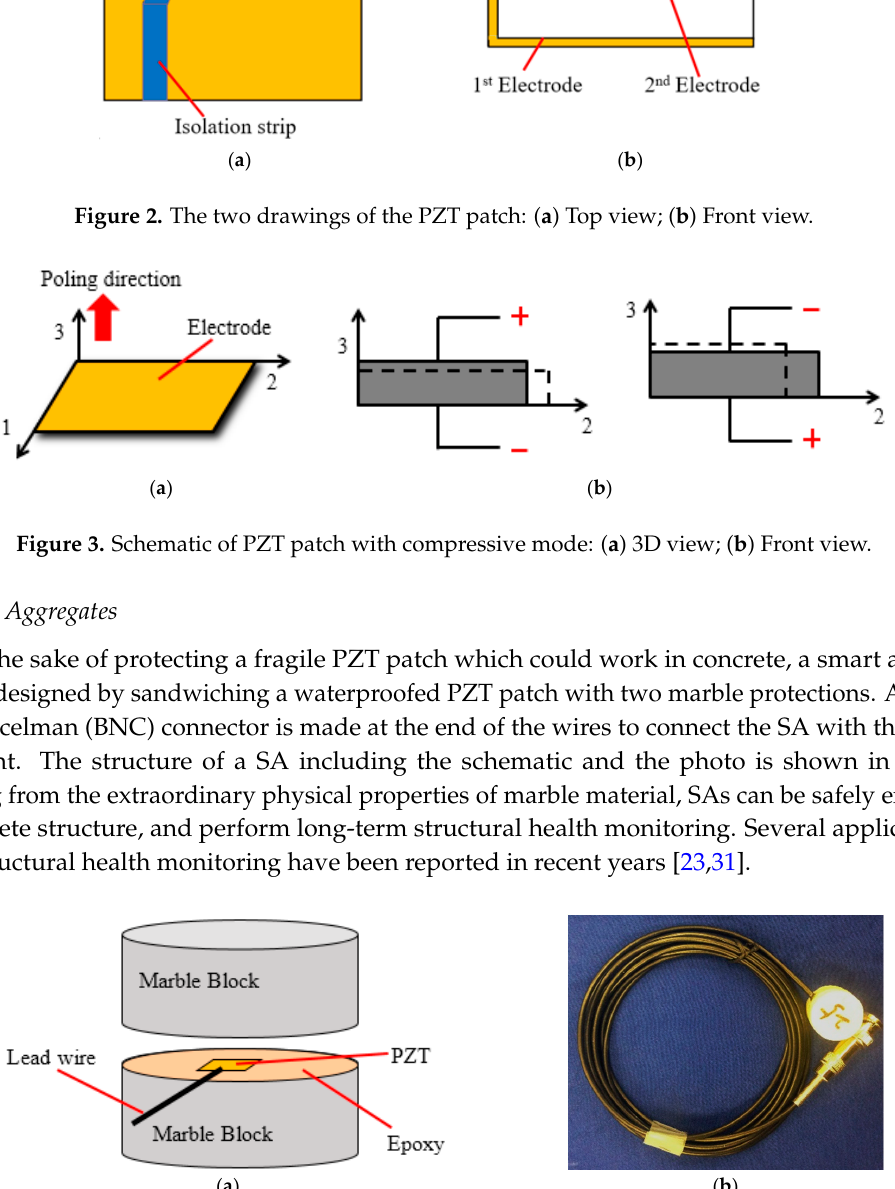
Figure 4. The structure of a smart aggregator: ( a ) Schematic; ( b ) A photo of SA with a BNC connector.